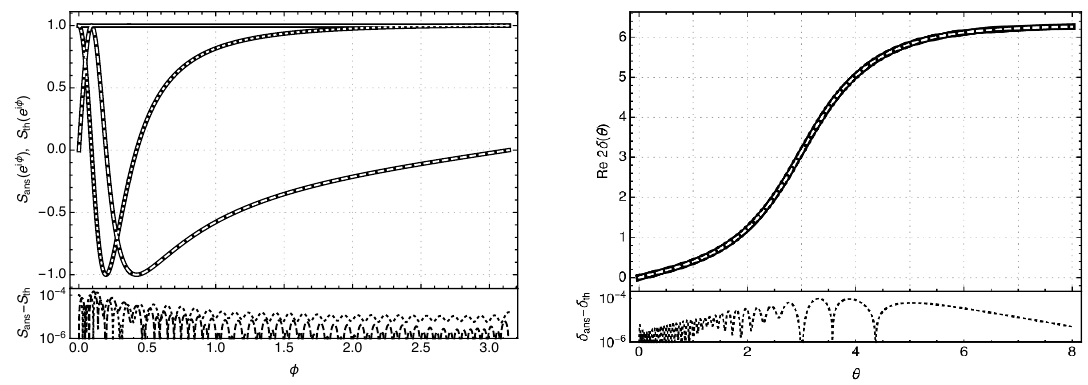
Figure 5 . In the left plot solid black lines depict the imaginary part, real part and absolute value of S th ( e i(cid:30) ). Superimposed we show the imaginary part (dashed white), the real part (doted white) and absolute value (solid white) of S ans ( e i(cid:30) ). In the lower left plot, sharing the same horizontal axis, we show the real part (dotted) and the imaginary part (dashed) of S th ( e i(cid:30) ) (cid:0) S ans ( e i(cid:30) ). Finally the plot to the right is a comparison of the phase of S ans (white) and S th (black) in the (cid:18)